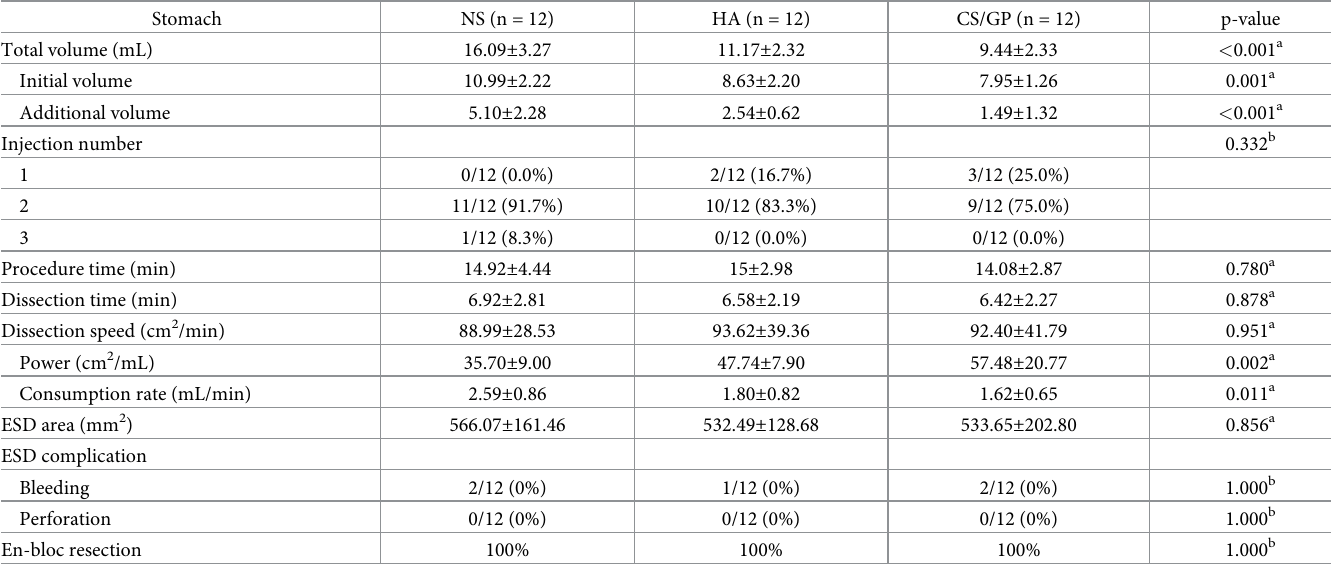
Table 2. Comparative gastric endoscopic submucosal dissection-related parameters between